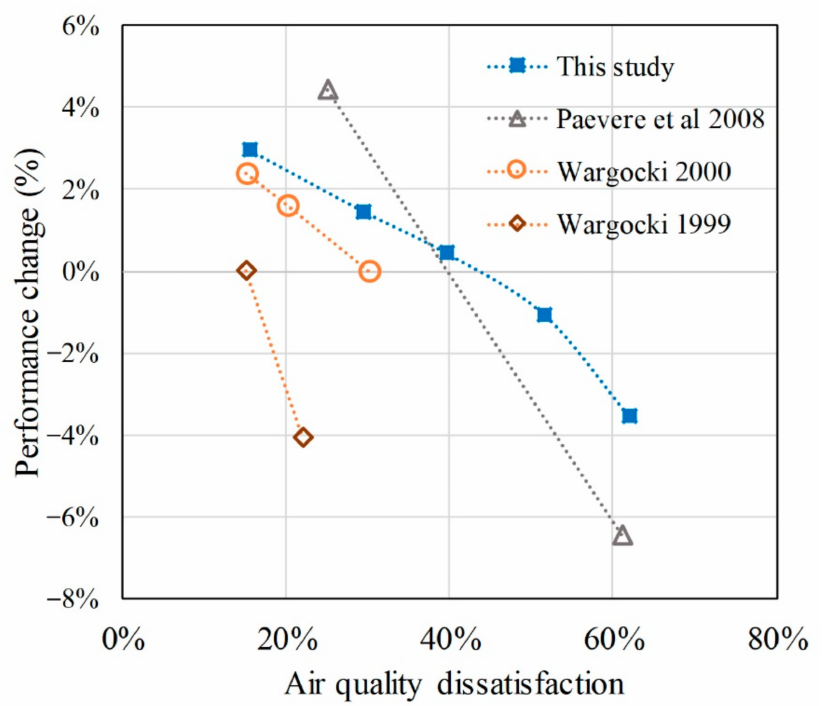
Figure 11. Comparison of the relationship between air quality dissatisfaction and performance change. Data sources: [22]; Wargocki 2000 [23]; Paevere et al. 2008